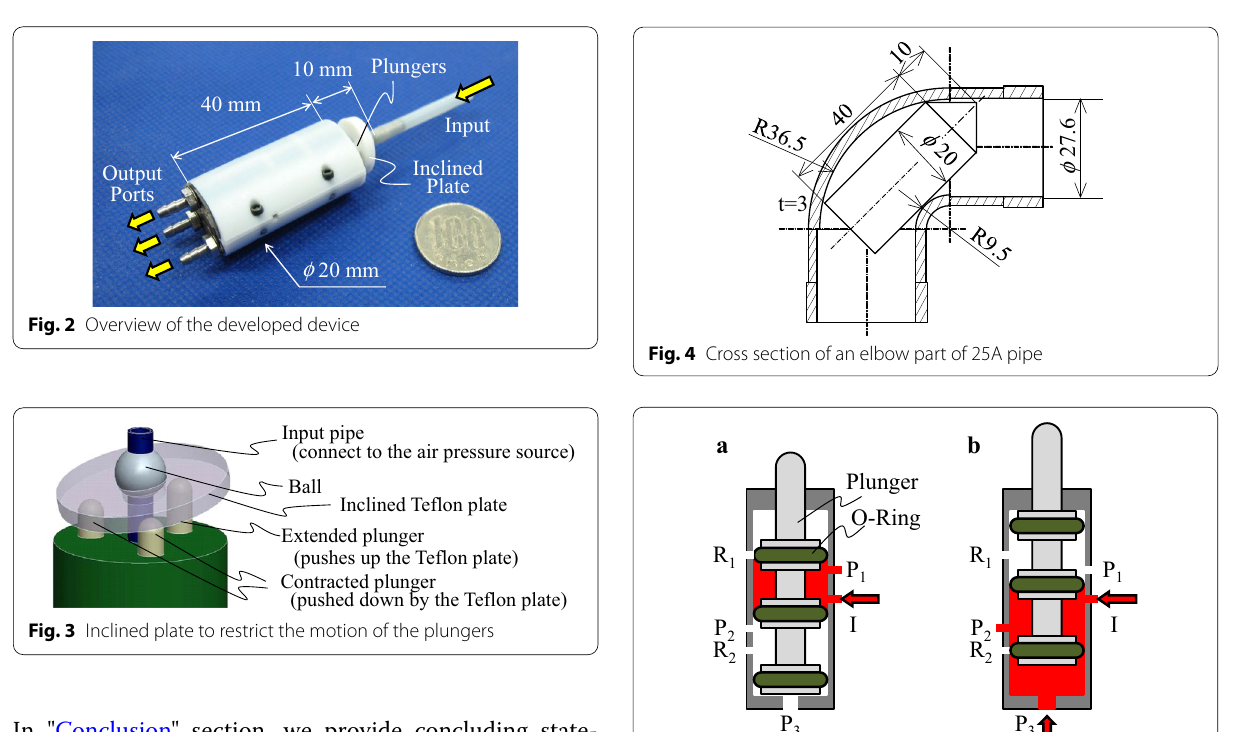
Fig. 5 Schematic diagrams of a plunger. a The plunger is contracted.